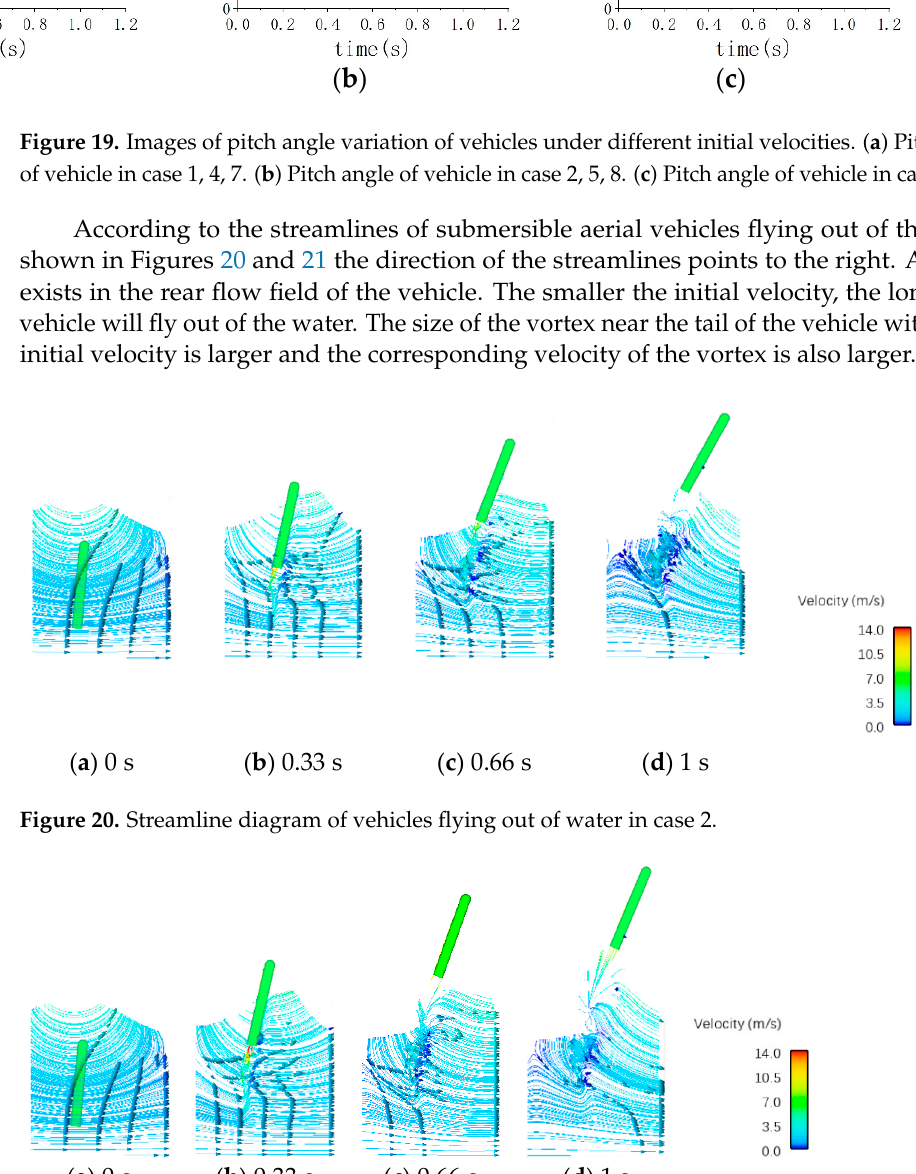
Figure 21. Streamline diagram of vehicles fl ying out of water in case 8.